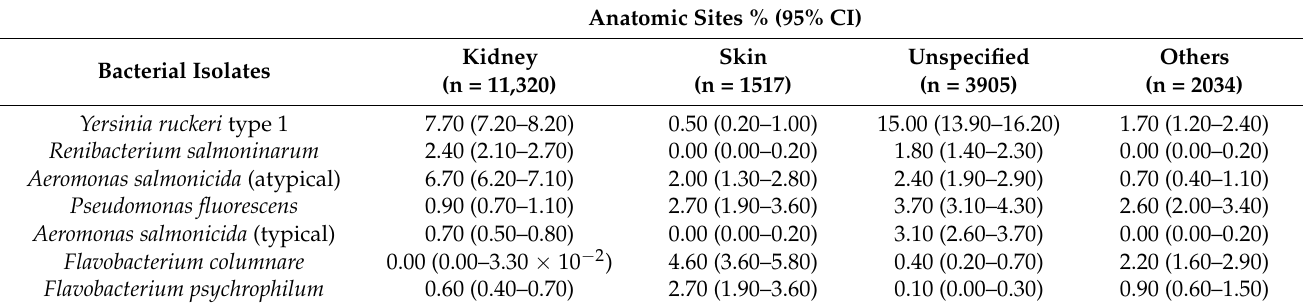
Table 2. Bacterial isolates detected from different anatomic sites of salmonids samples submitted to the AVC ADSBL